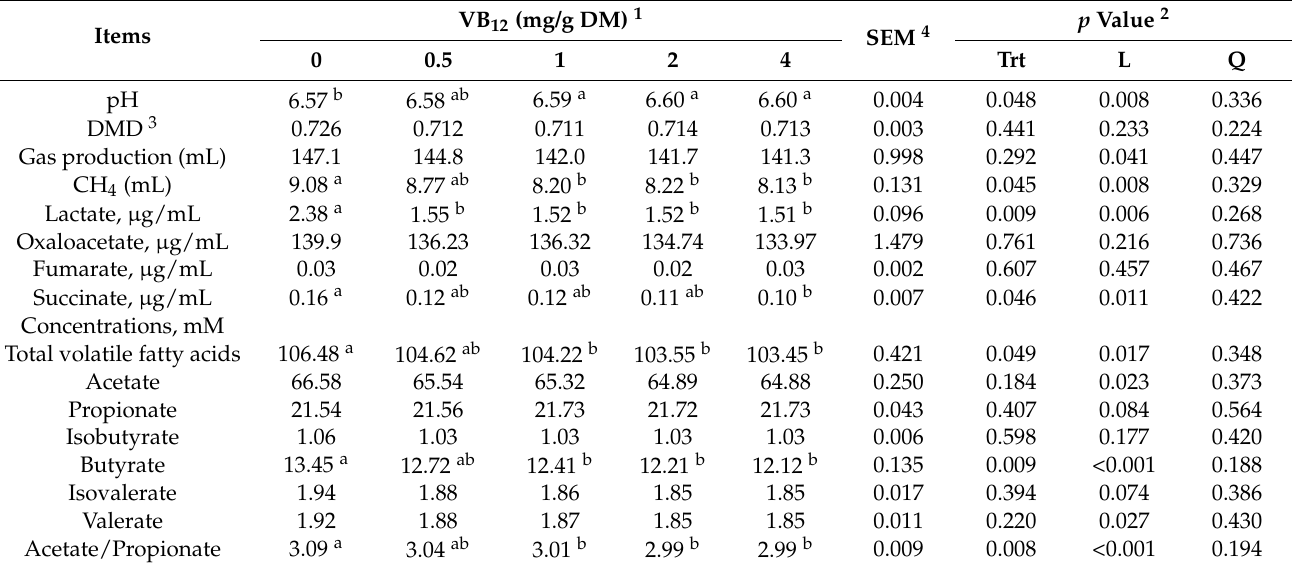
Table 1. Effects of vitamin B 12 supplementation on fermentation